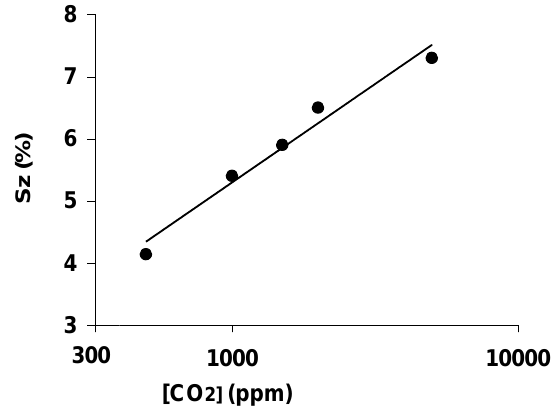
Figure 7. Sensitivity to carbon dioxide within a range 500 to 5,000 ppm, measured at 300  C and 40% RH in terms of impedance